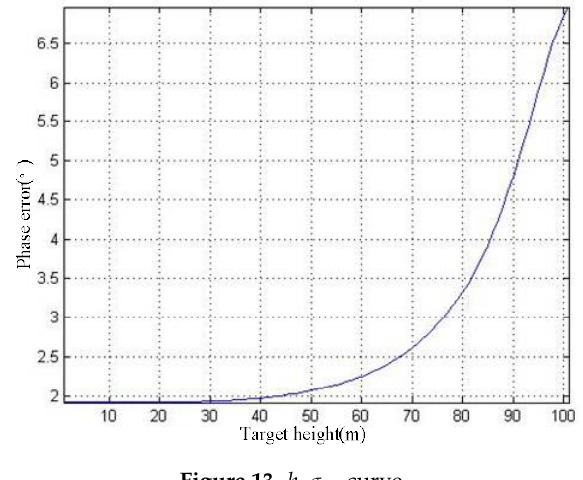
Figure 13. h – σ ps curve.